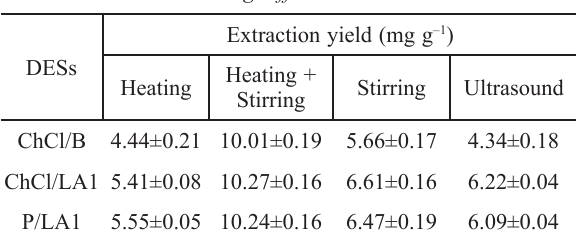
Table 3 – Amount of flavonoids extracted from Ginkgo bilo- ba leaves using different extraction methods a